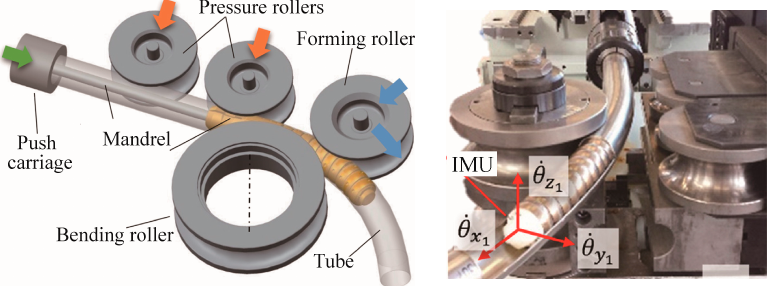
Figure 13. Tools and main kinematics in the three roll push bending (TRPB) process. Reproduced with permission from ref. [56]. Copyright 2017 Published by Elsevier Ltd. on behalf of CIRP.